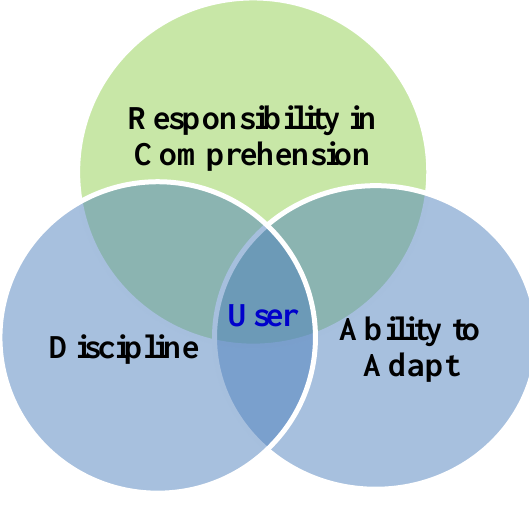
Figure 4. Key themes in scientific software user